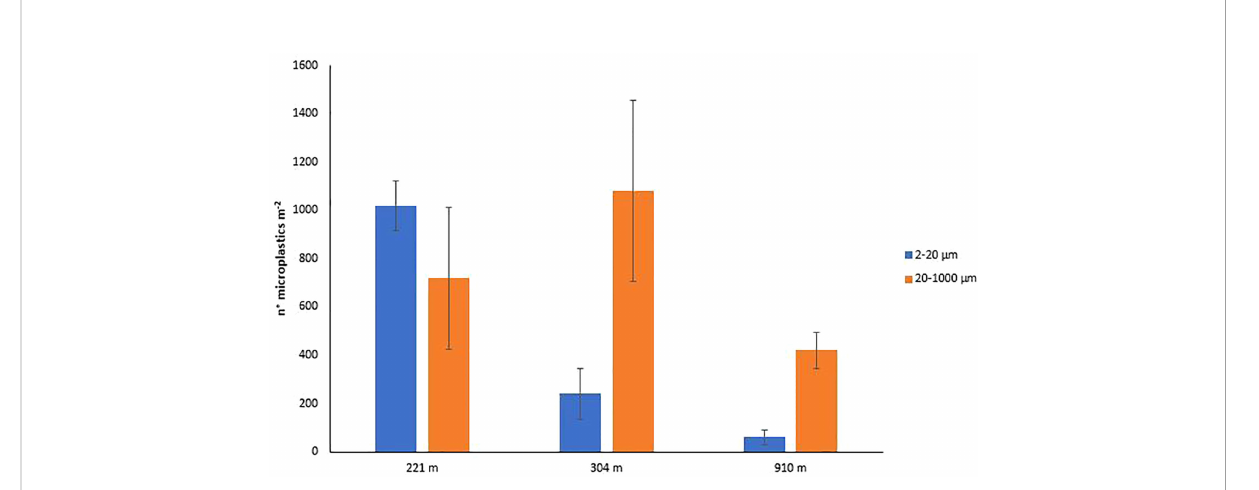
FIGURE 6 Microplastic abundance (size ranges: 2-20 and 20-1000 µm) in the deep-sea sediments of the San Gregorio canyon.